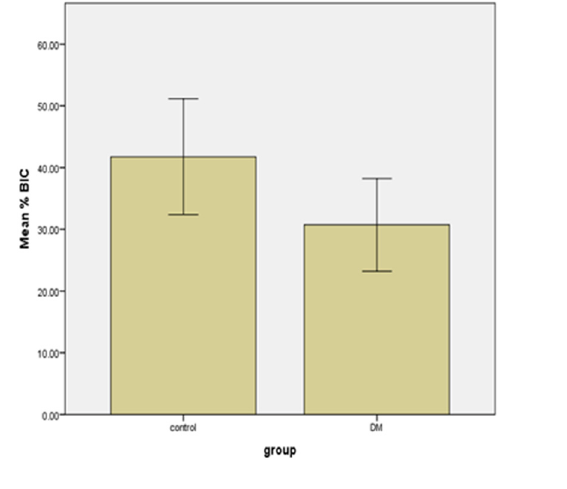
( b ) ( c ) Figure 7. Correlation between fasting glucose (FG) and HbA1c ( a ), HbA1c and %BIC ( b ), HbA1c and % bone formation ( c ). There was a strong correlation between increased HbA1c and decreased BIC ( p < 0.05) and decreased new bone formation ( p < 0.05). 4. Discussion T2DM is the most common form of all DM and the number of affected patients were on the rise. T2DM was linked to being overweight and obese [6]. BMI and waist circumference are the most